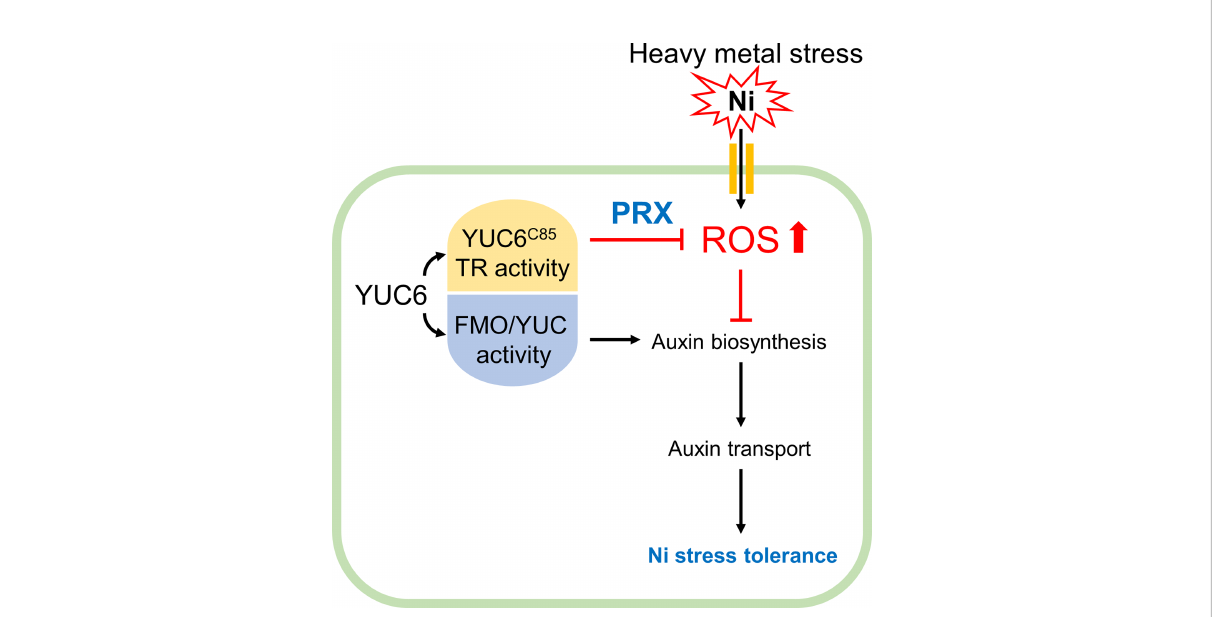
FIGURE 8 Proposed model for acquiring Ni stress tolerance through TR activity of YUC6 in Arabidopsis. Ni heavy metal stress mediates ROS production and inhibits auxin biosynthesis and distribution resulting in growth retardation. YUC6 has dual enzyme activities as an FMO/YUC activity and Cys85- dependent TR activity for auxin biosynthesis and ROS inhibition, respectively. Inhibition of auxin biosynthesis increased Ni toxicity, suggesting that maintenance of auxin homeostasis is necessary for basal Ni stress tolerance. Overexpression of YUC6 enhanced Ni stress tolerance in Arabidopsis, and its tolerance is due to the TR activity of YUC6. Thus, the TR activity of YUC6 is predominantly involved in Ni stress tolerance rather than elevated auxin levels in Arabidopsis. Furthermore, under Ni stress conditions, YUC6 promotes the antioxidant enzyme PRX activity and transcription of PrxQ . Collectively, YUC6 positively regulates Ni stress tolerance via its TR